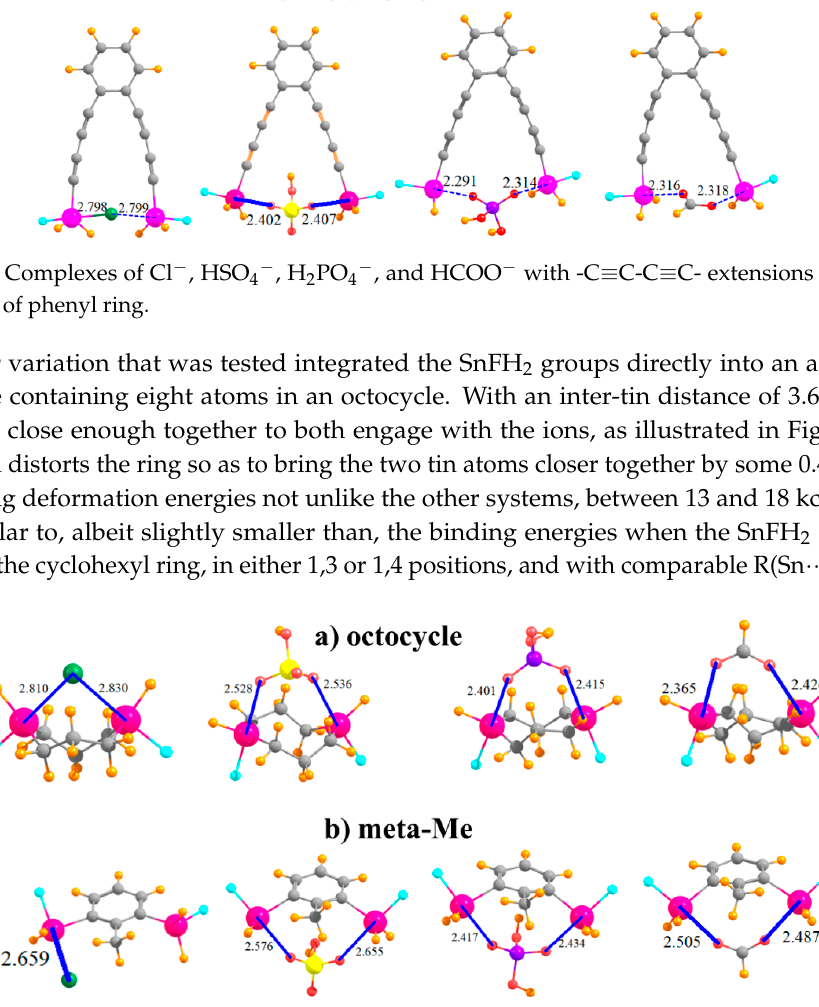
Figure 7. Complexes of Cl − , HSO 4 − , H 2 PO 4 − , and HCOO − with SnFH 2 groups ( a ) embedded in 8-membered ring, and ( b ) in 2,6 positions of toluene.